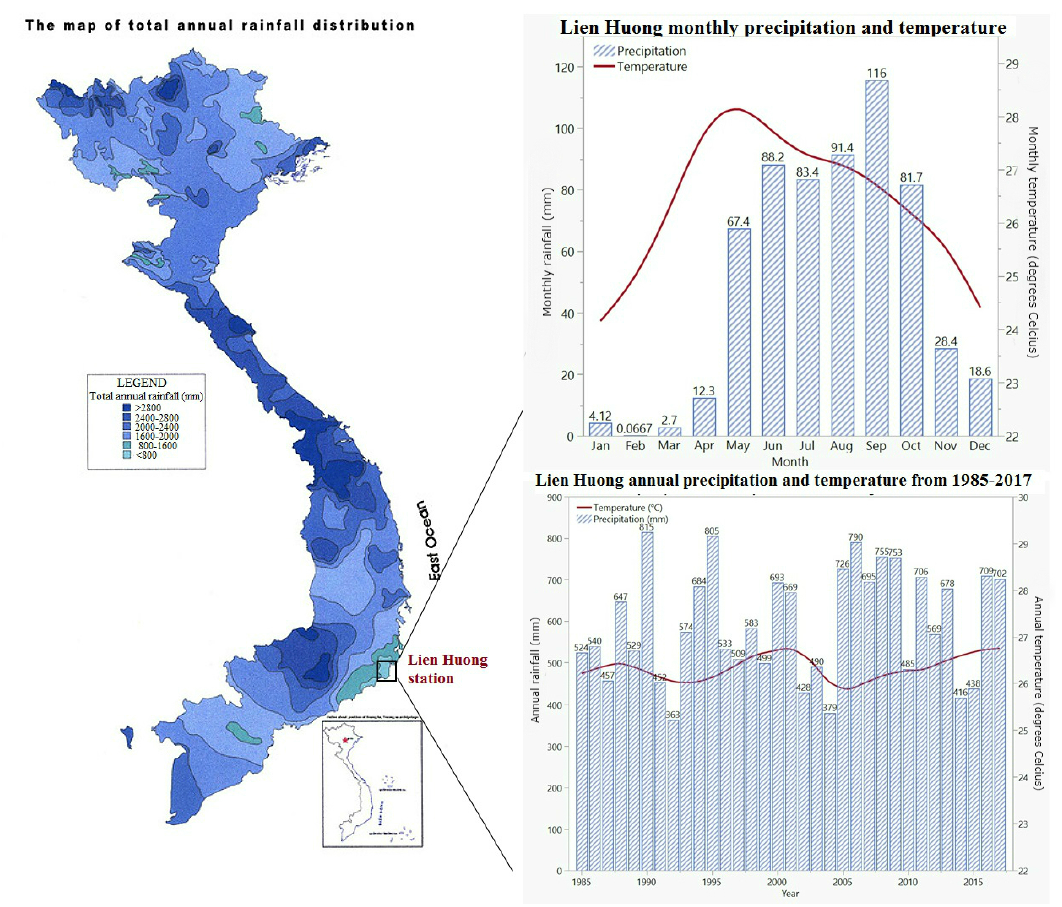
Figure 3. Map of total annual rainfall distribution of Vietnam (source: The center of database establishment for Environmental resources in Vietnam, Geography institute (1999) [12]; and charts of monthly and annual precipitation and temperature report at Lien Huong station during 1985–2017 (meteoblue.com